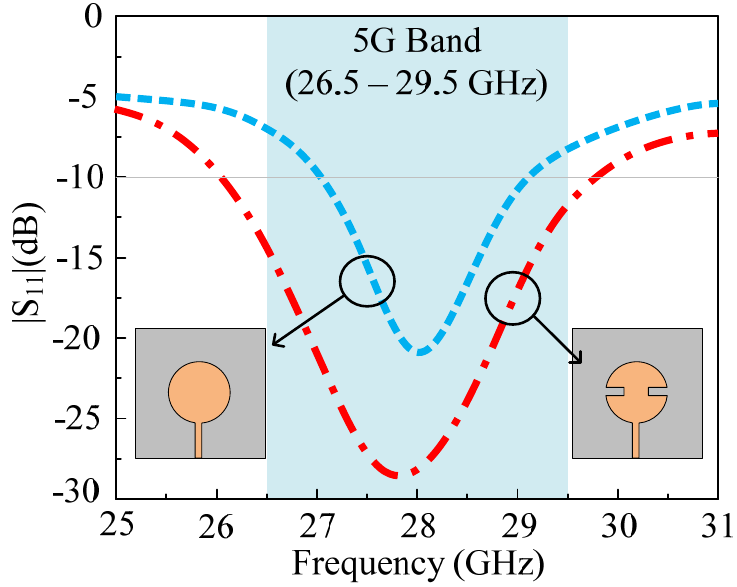
Figure 2. Comparison of S-parameter of proposed single element circular patch antenna with and without rectangular slits.